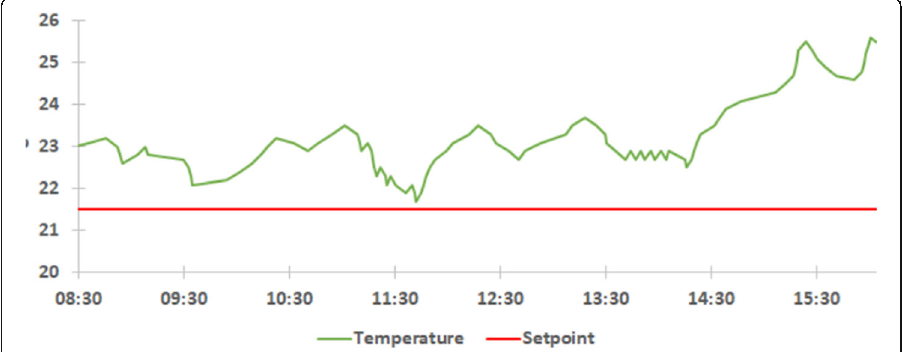
Fig. 8 Measured temperature and temperature setpoint observed on October 24th, 2018 during default